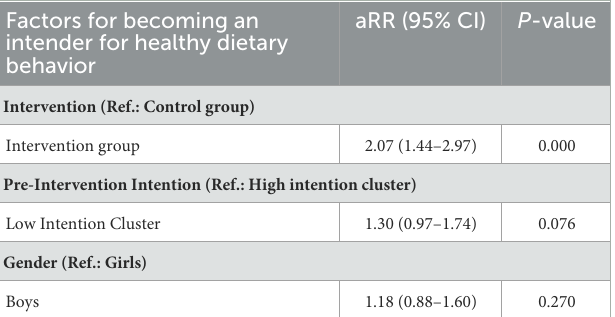
TABLE 6 General linear model showing different factors of improved intention for healthy dietary